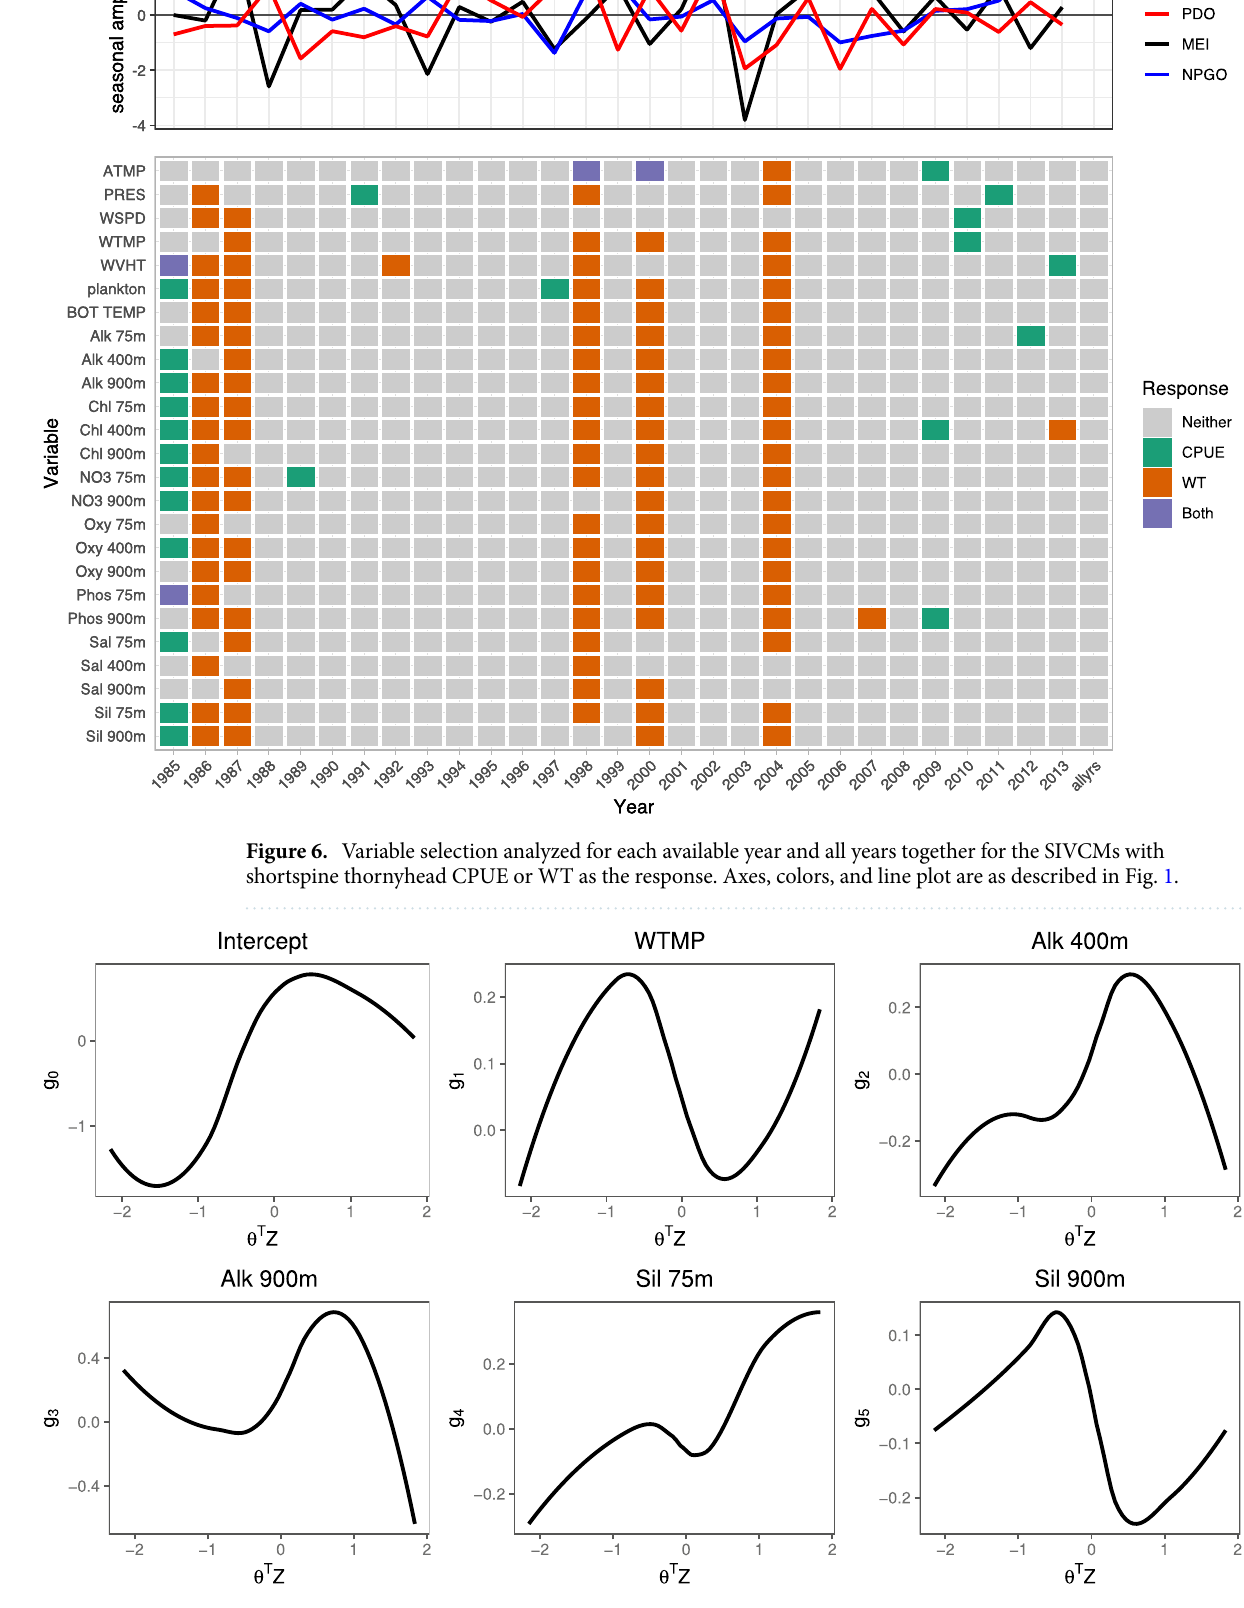
Figure 7. Coefficient functions selected and estimated by LSSGLASSO as important predictors of sablefish